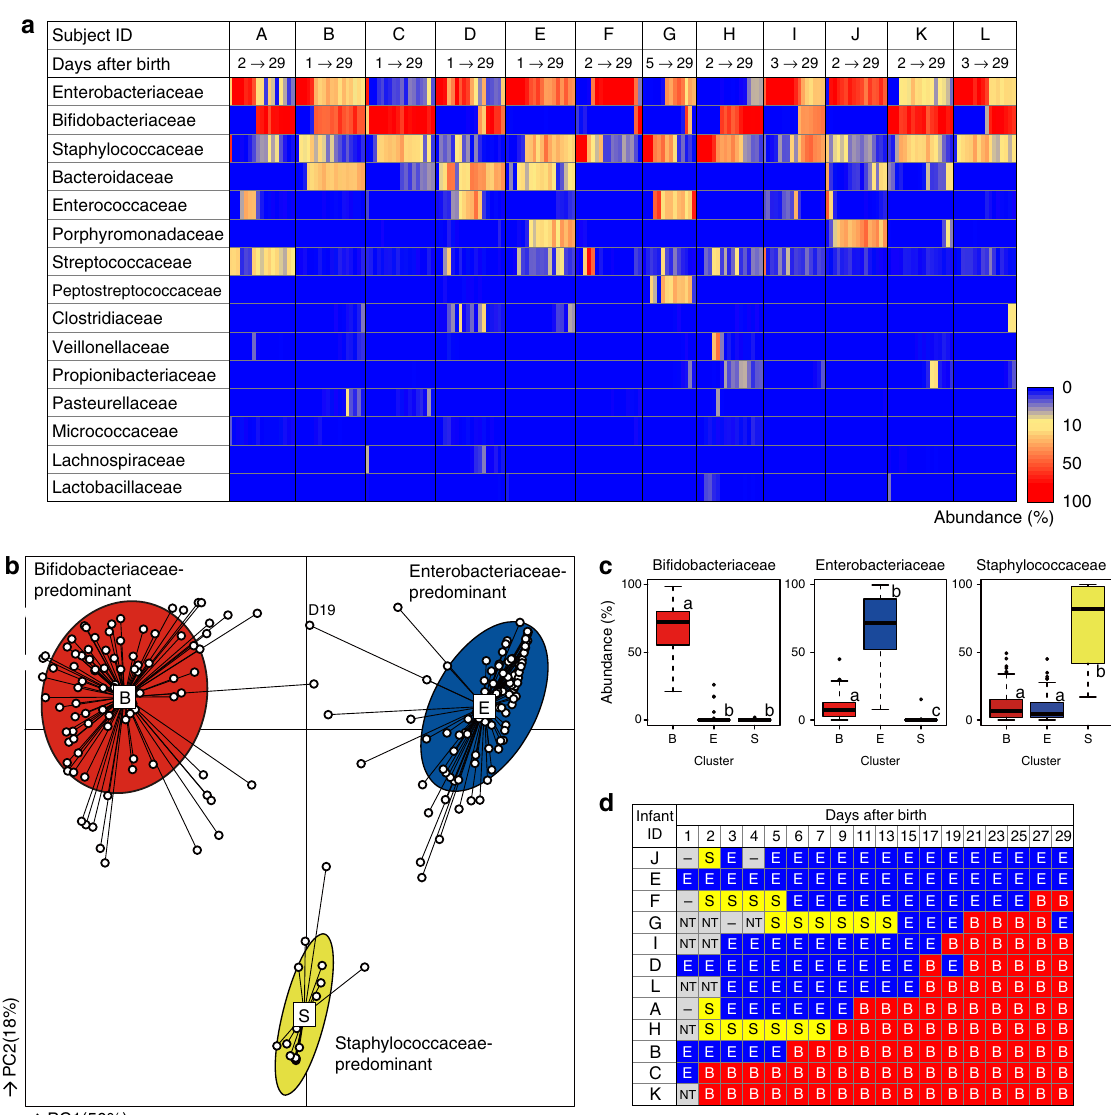
Figure 1 | Infant gut microbiota community profiles during the first month of life. ( a ) Microbiota profiles in stool samples from 12 subjects ( n ¼ 202; B 17 sampling days per subject), temporally ordered from left to right. Each row represents taxonomic groups at the family level. The top 15 families are displayed and sorted according to relative abundance. Abundances are represented using the colour scale. ( b ) Characteristics of infant gut microbiota, illustrated by PCoA and PAM clustering analyses. Data from individuals (points) were clustered, and the centres of gravity (rectangles) were computed for each class. The coloured ellipses encompass 67% of the samples in each cluster. ( c ) Box plots showing the relative abundances of the main contributors to each cluster. Different letters (a–c) above the boxes indicate significant differences between clusters ( P o 0.05, Mann–Whitney U -test with Bonferroni’s correction). ( d ) Temporal shift from Staphylococcaceae- or Enterobacteriaceae-dominant microbiota to Bifidobacteriaceae-dominant microbiota. S, Staphylococcaceae-dominated (yellow); E, Enterobacteriaceae-dominated (blue); B, Bifidobacteriaceae-dominated (red); NT, not tested; —, sample not